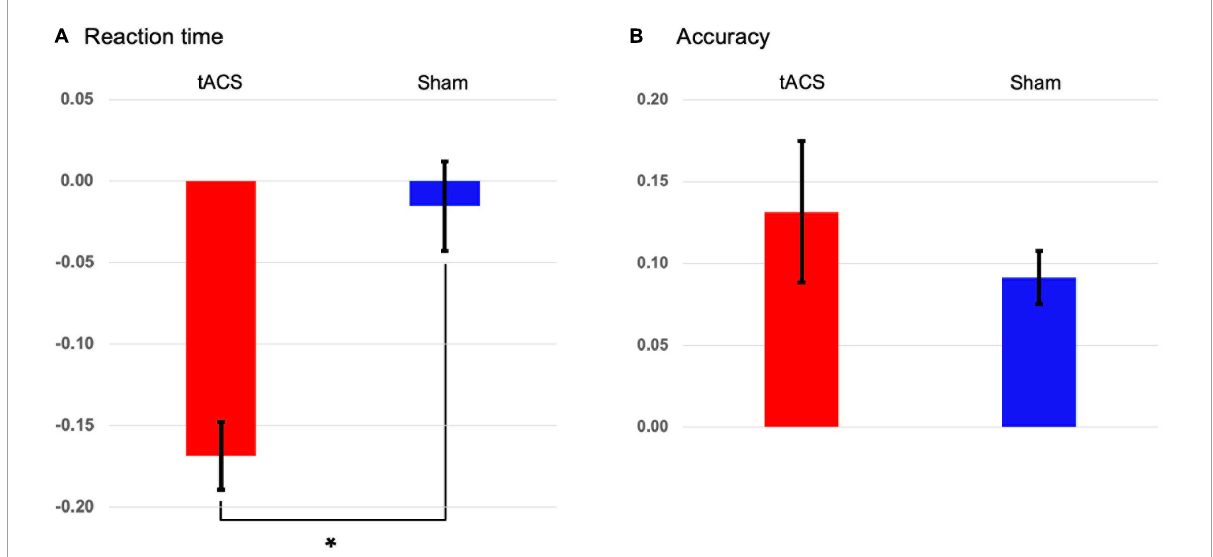
FIGURE3 Transcranial alternating current stimulation (tACS)-mediated changes in the behavioral data. The normalized changes between pre- and post-treatment (post-treatment minus pre-treatment) in (A) reaction times and (B) accuracies of task performance in both the tACS-treated (red bars) and sham (blue bars) groups. The error bars indicate the standard errors of the mean, and the asterisk represents statistical significance ( p < 0.001).